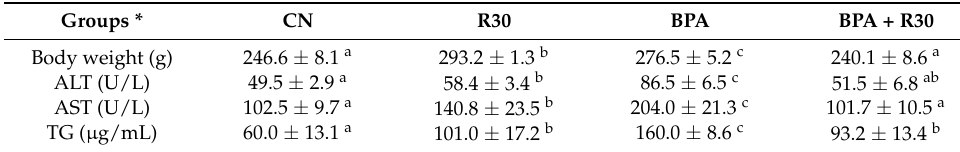
Figure 1. ( A ) Effects of bisphenol A (BPA) and resveratrol ester on gene expression in the livers of male offspring rats. A: SOD1 gene expression in the liver. B: SOD2 gene expression in the liver. C: Gpx1 gene expression in the liver. D: Gpx2 gene expression in the liver. E: Catalase gene expression in the liver. ( B ) Effects of BPA and resveratrol ester on antioxidant enzyme activity of male offspring rats. A: SOD activity (U/g) in male offspring rats. B: GSH (mg/L) in male offspring rats. C: Catalase activity (U/mg) in male offspring rats. n = 4–8 per group; a–c p < 0.05, significantly different from other groups. CN = control group; R30 = group administered 30 mg/kg/day of resveratrol butyrate ester (RBE); BPA = group administered bisphenol A at 50 µ g/kg/day; BPA + R30 = group administered 30 mg/kg/day of RBE and bisphenol A. Table 1. Plasma biochemical parameters of male offspring